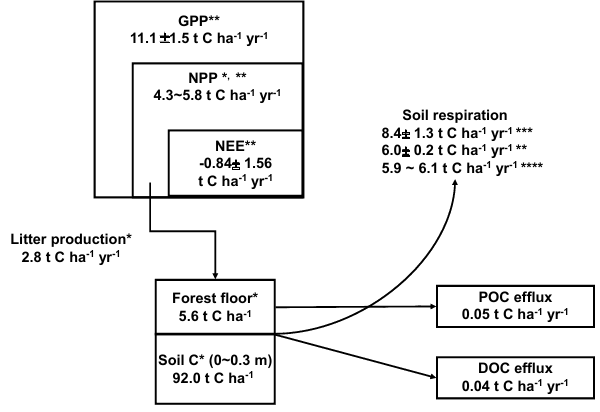
Fig. 7. The contribution of DOC and POC to the carbon budget in the Gwangneung deciduous forest catchment. * Lim et al. (2003: observation periods 1998 to 1999), ** Kwon et al. (2010: observa- tion periods 2006 to 2008), *** Chae (2008: observation periods 2001 to 2004), **** Lee et al. (2010: observation periods 2005 to 2006). The difference of soil respiration is due to difference of ob- servation periods and